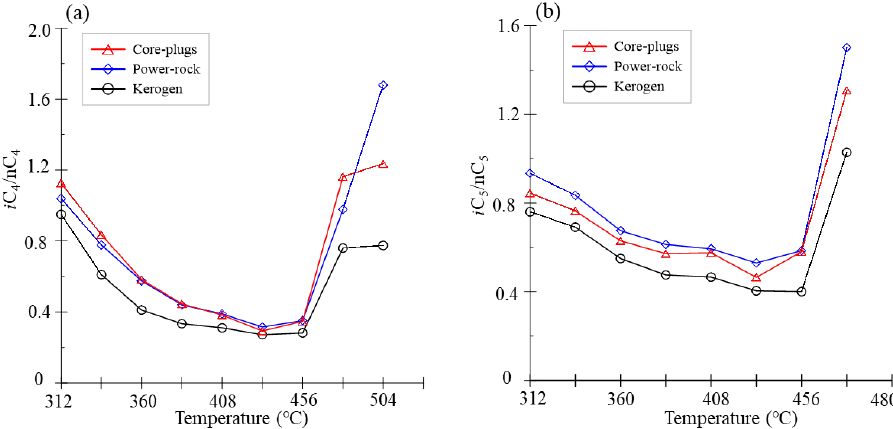
Figure 7. The isomerization ratio varies with temperature. ( a ) i C 4 /nC 4 ; ( b ) i C 5 /nC 5 .